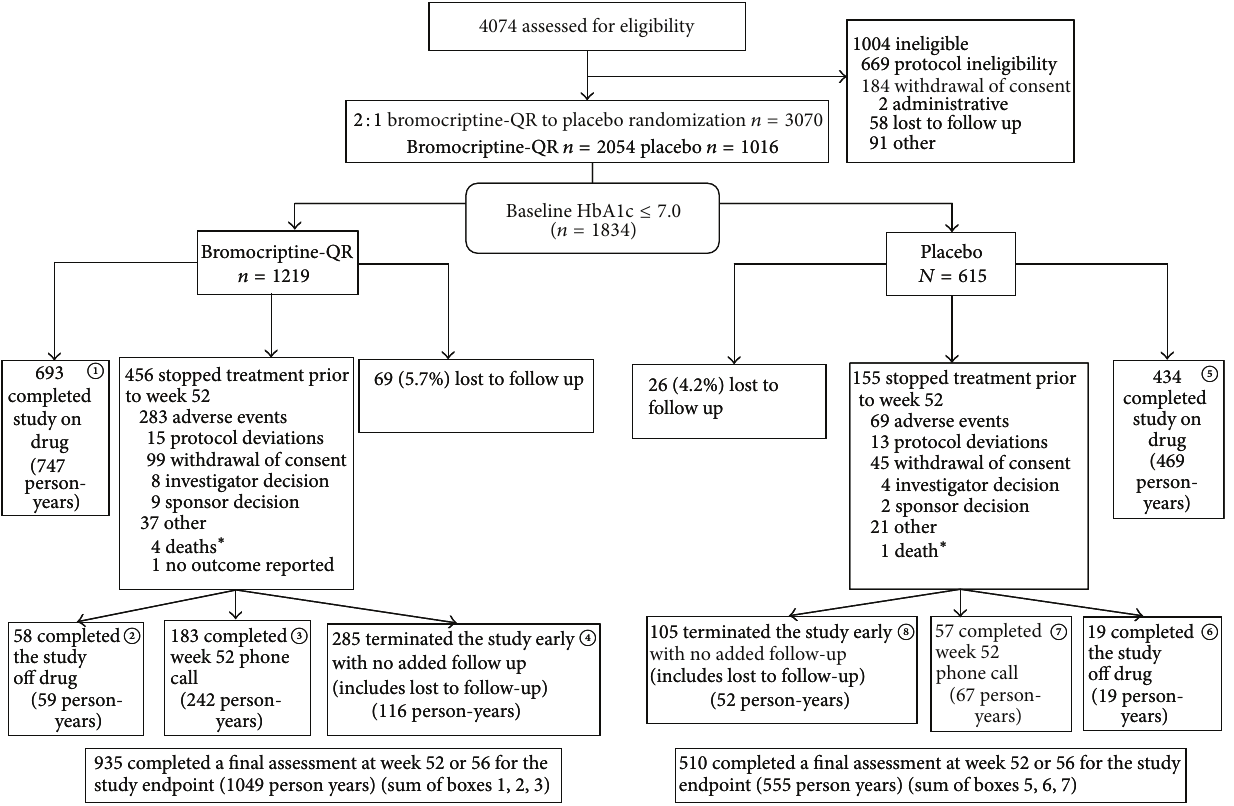
Figure 1: Disposition of study